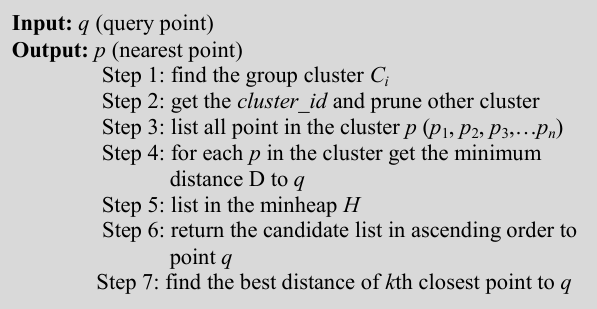
Figure 3. k Nearest Neighbour